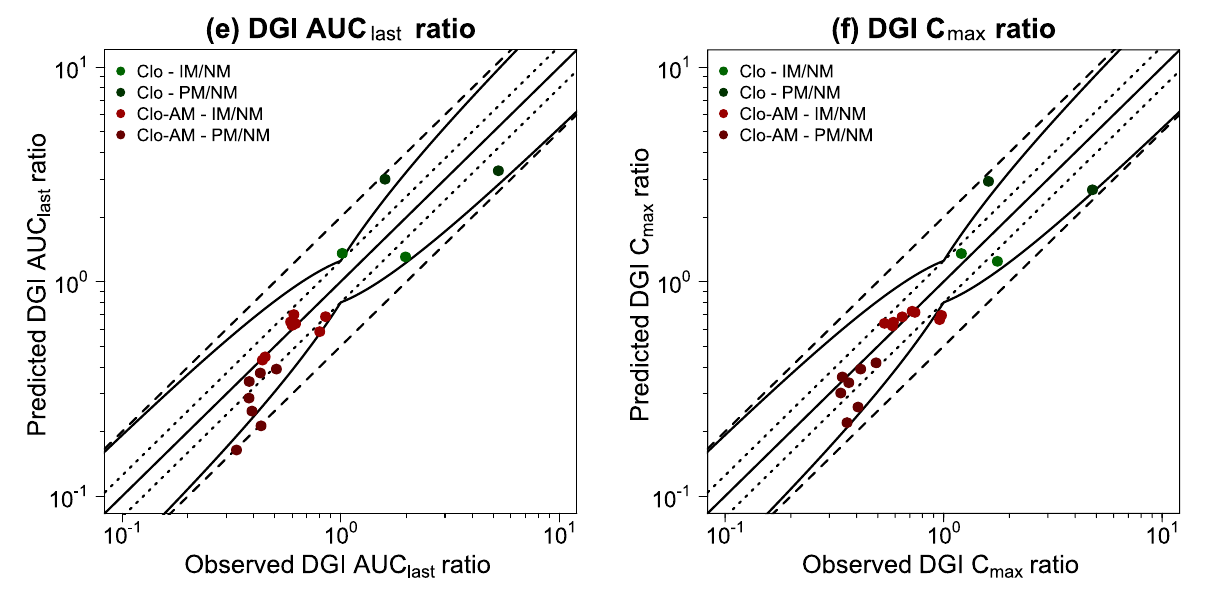
Figure 4. Drug–gene interaction model evaluation. Presented are examples of predicted plasma concentration-time profiles of ( a , b ) clopidogrel and ( c , d ) Clo-AM for IM and PM phenotypes compared separately to NM phenotypes, alongside corresponding observed data [48,51]. Dashed (IM or PM) and solid (NM) lines represent the model predictions, while corresponding observed data are shown as symbols ( ± standard deviation, if available). Predicted versus observed ( e ) DGI AUC last and ( f ) DGI C max ratios are shown with the solid line representing the line of identity, dotted lines indicating 1.25-fold, and dashed lines 2-fold deviation from the respective observed value, along with the curved lines marking the prediction success limits proposed by Guest et al. [75] (including 20% variability to account for uncertainties in observed ratios). Detailed information on all DGI studies as well as individual DGI AUC last and DGI C max ratios are provided in Tables S8 and S9 of the Supplementary Materials. AUC last : area under the plasma concentration-time curve determined between first and last concentration measurements, Clo: clopidogrel, Clo-AM: clopidogrel